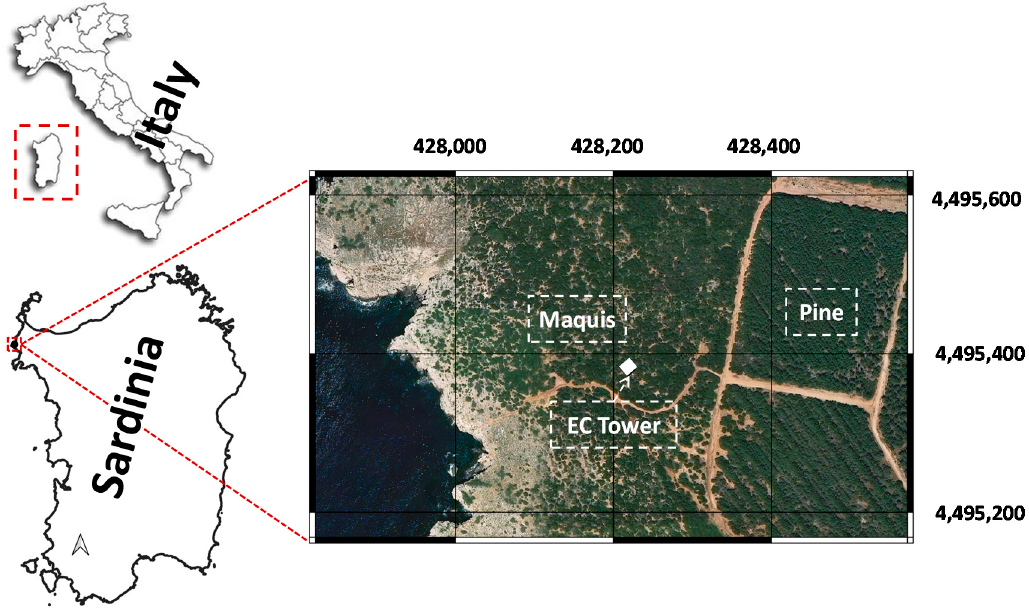
Figure 1. Geographic location of the micro-meteorological IT-Noe station in the Le Prigionette natural reserve, Italy. Coordinates EPSG:32632 (WGS 84/UTM zone 32N). The white square indicates the position of the eddy covariance tower.